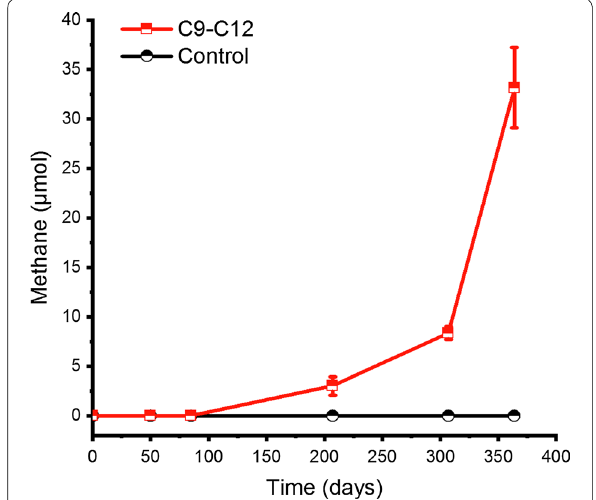
Fig. 1 Methane produced over time in the